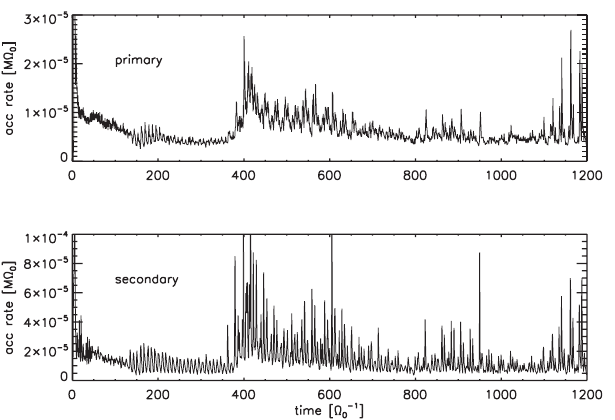
Figure 6. Evolution of the semi-major axis of the binary driven by its interaction with the stars formed in the circumbinary